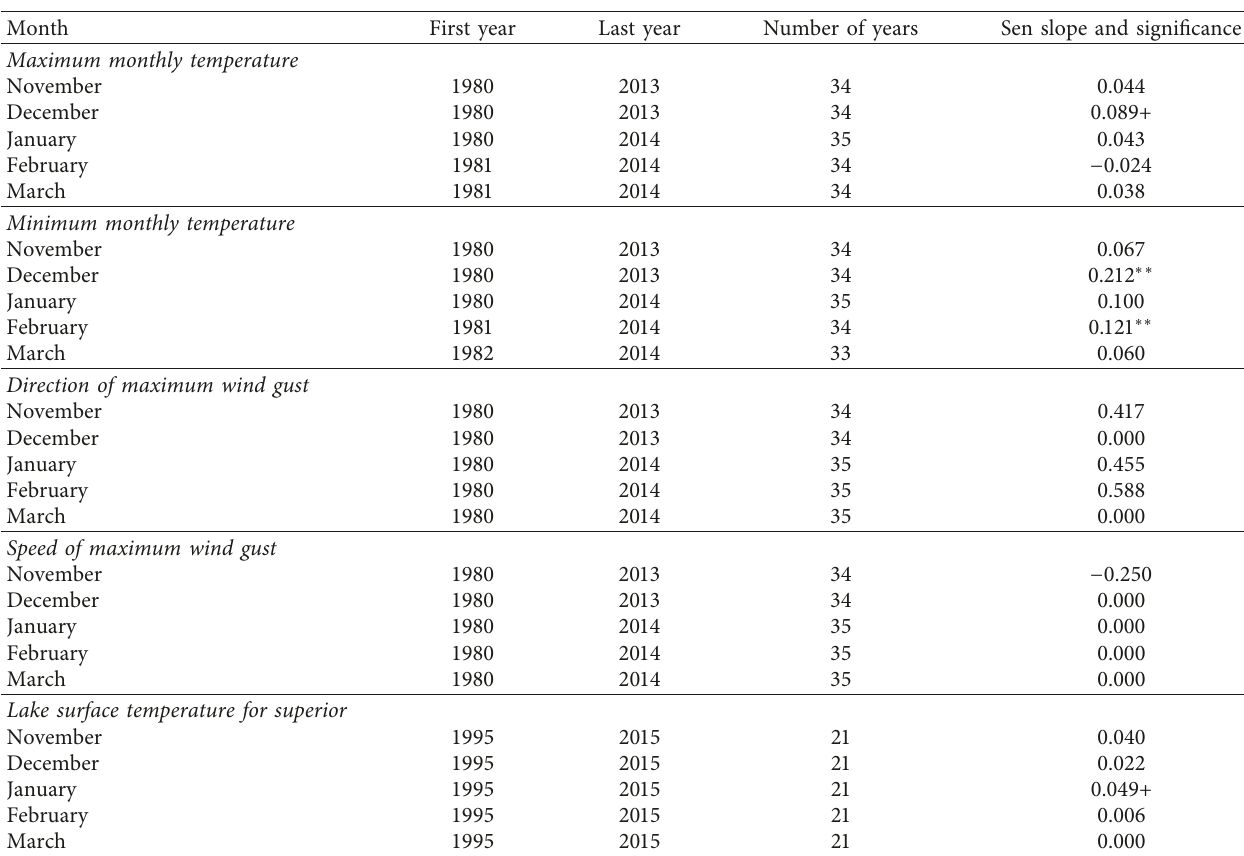
Figure 9:1980 to 2015 trend in extreme snowfall intensity for the month of March. Gray pixels represent grid cells with no trend computed because the region contains some years with no extreme snowfall values. Table 3: Predictor variable trend analysis for each month of the cold season with corresponding years used in Sen slope calculation for Wawa,